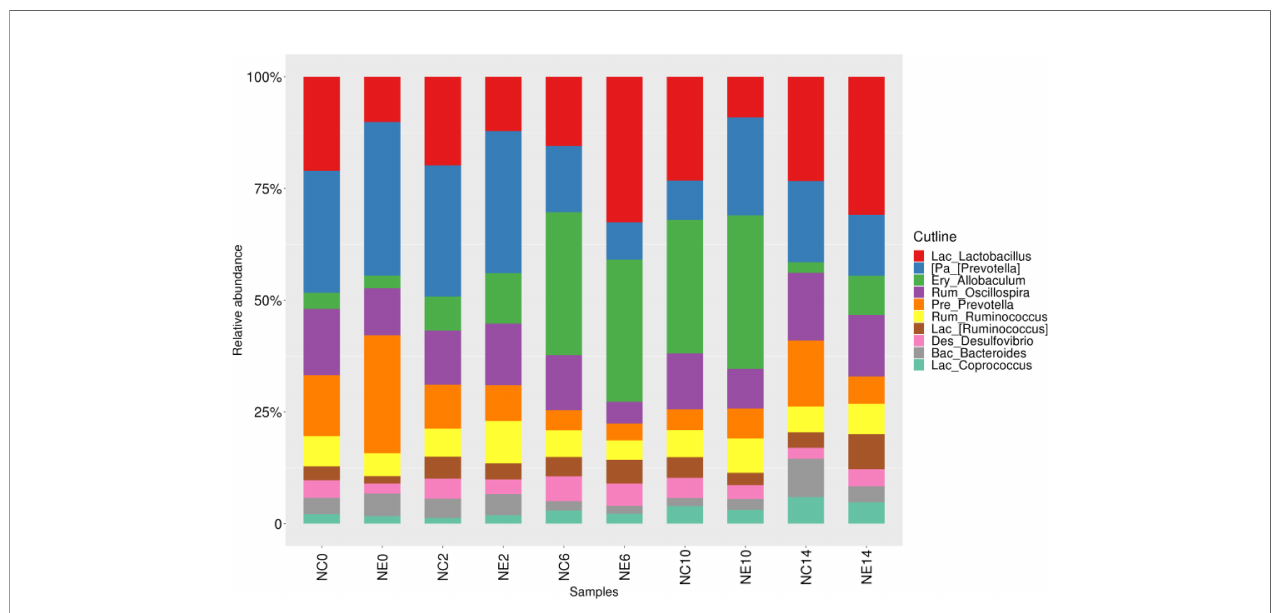
FIGURE 6 | Histogram of the gut microbiota at the genus level in the control (NC) and exercise (NE) groups at each time point. The ordinate represents the relative abundance of genera. Different colors represent different